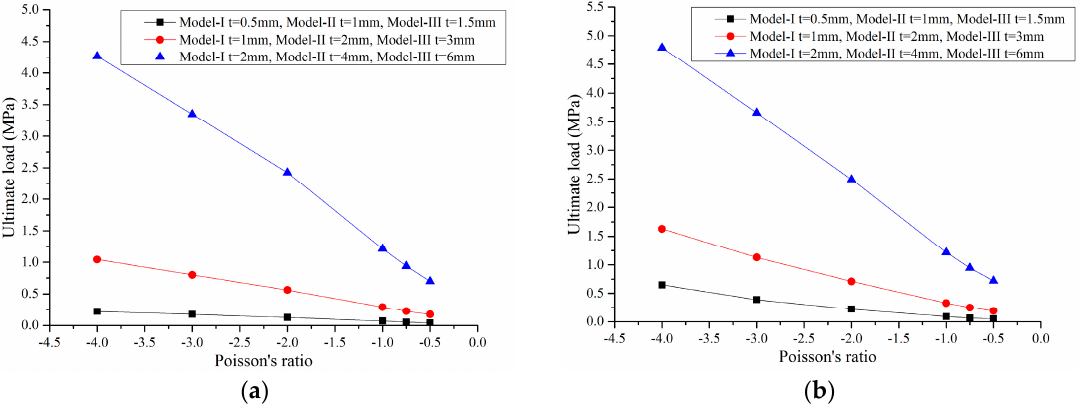
Figure 7. The ultimate bearing capacity of the honeycombs for different Poisson’s ratios under ( a ) compression and ( b ) tension.